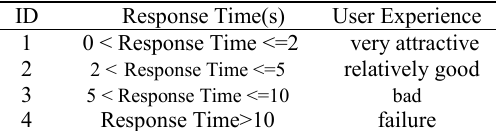
Table 1. The correspondence between response timea and user